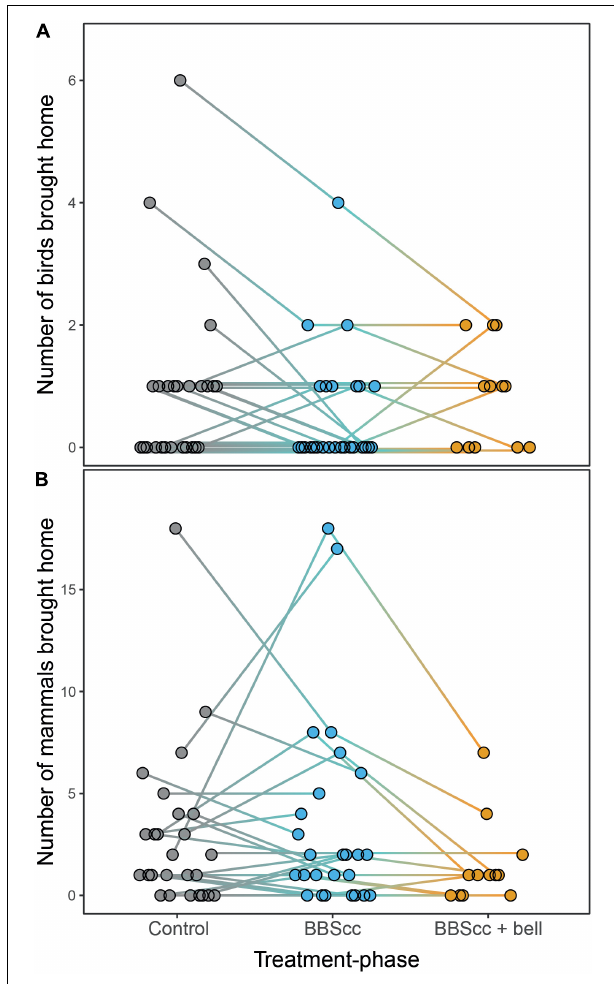
FIGURE 3 | Number of birds (A) and mammals (B) brought home by 2-week treatment-phase. Dots are individual prey numbers per household. Lines between treatment phases connect data of the same household. Control = study cats wearing neither Birdsbesafe collar-covers (BBScc) nor bell; BBScc = study cats wearing a BBScc (treatment 1); BBScc + bell = study cats wearing a BBScc plus a bell (treatment 2; only for extended survey in a subset of households). For sample sizes see Table 1 . For individual prey numbers per cat, see Supplementary Data Sheet 2